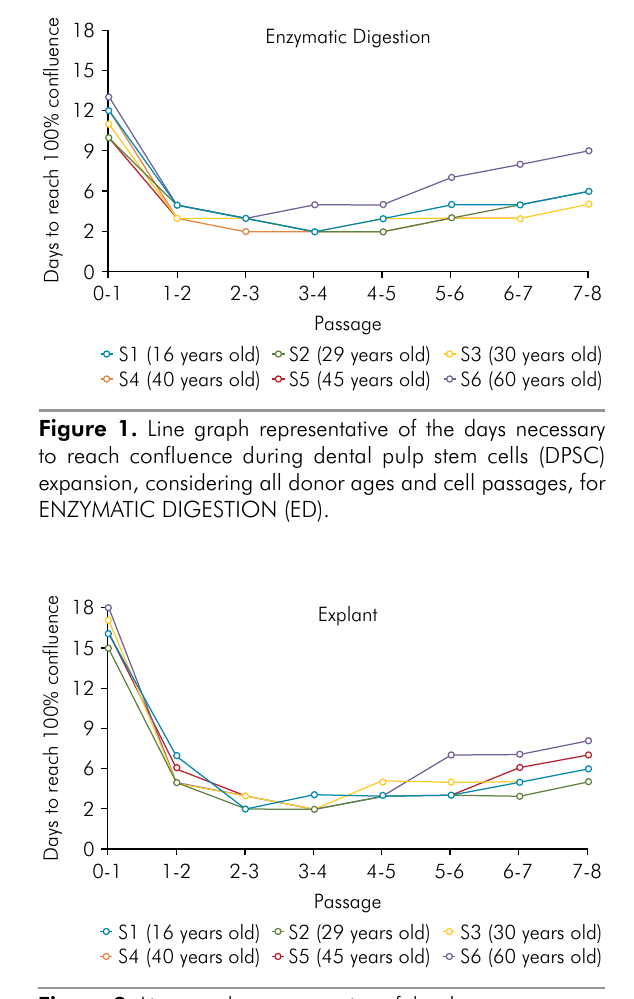
Figure 2. Line graph representative of the days necessary to reach confluence during DPSC dental pulp stem cells (DPSC) expansion, considering all donor ages and cell passages for EXPLANT